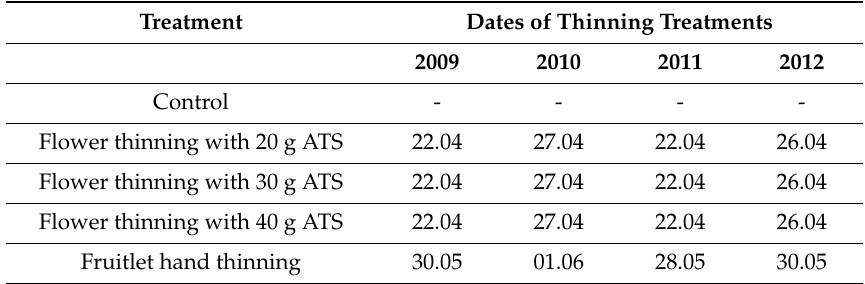
Table 1. Dates of thinning of ‘Regina’ sweet cherry trees in